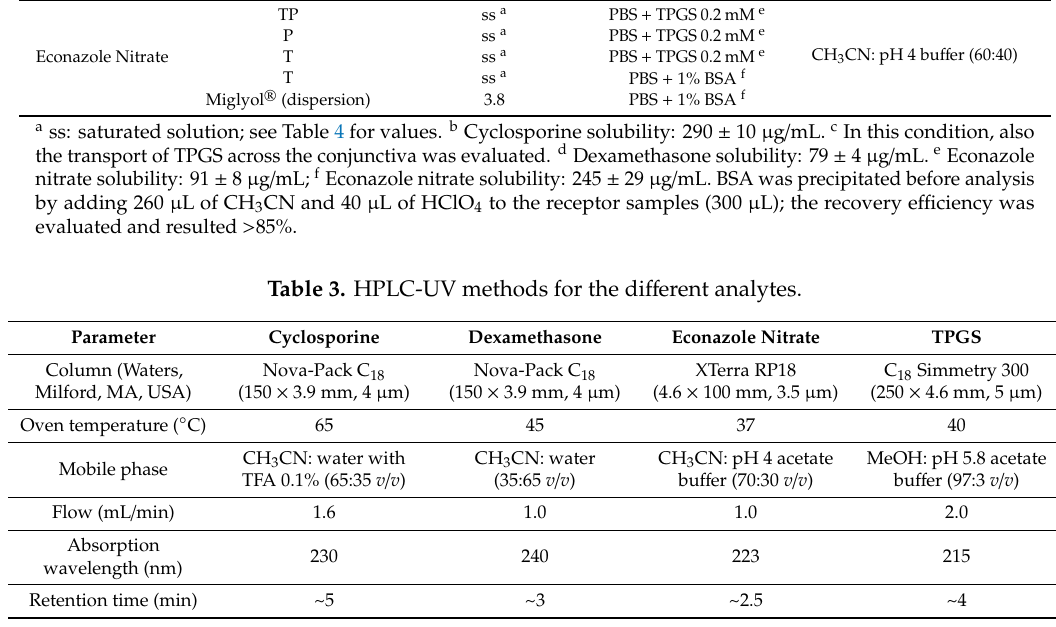
a ss: saturated solution; see Table 4 for values. b Cyclosporine solubility: 290 ± 10 µ g / mL. c In this condition, also the transport of TPGS across the conjunctiva was evaluated. d Dexamethasone solubility: 79 ± 4 µ g / mL. e Econazole